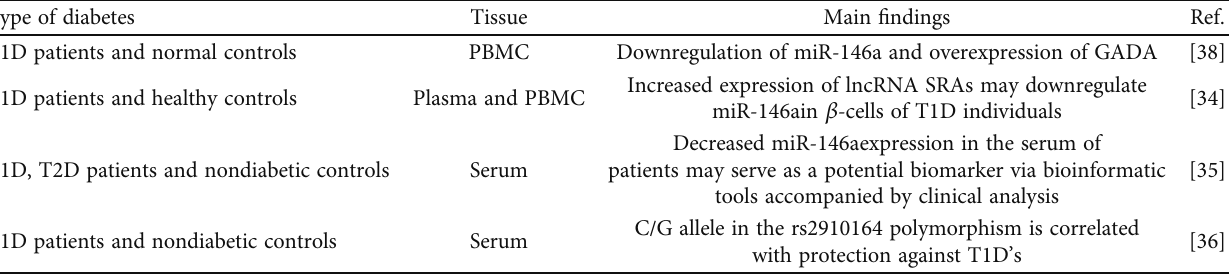
Table 1: Clinical investigations on the correlation of miR-146a with